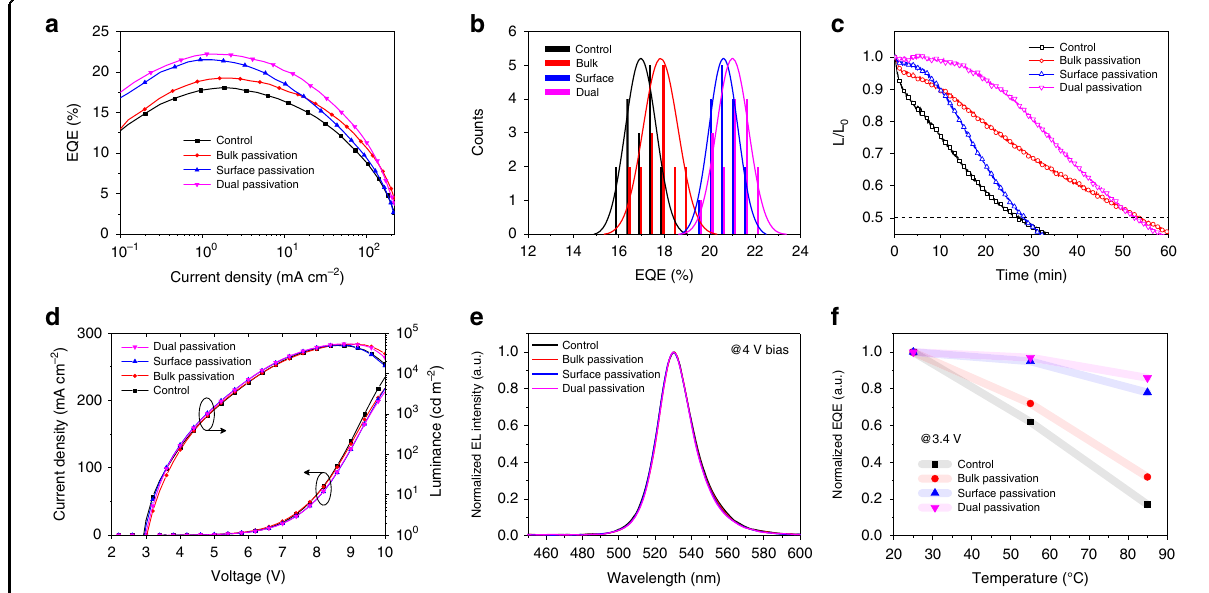
Fig. 4 Optoelectronic characteristics of the quasi-2D PeLEDs. a Current density-EQE curves, b histograms of peak EQEs, c operation stability at a initial luminance of 100 cd m − 2 , d current density-voltage-luminance characteristics and e EL spectra of PeLEDs based on perovskite emitters without and with different passivation strategies. f Normalized EQE comparison of PeLEDs from RT to 85